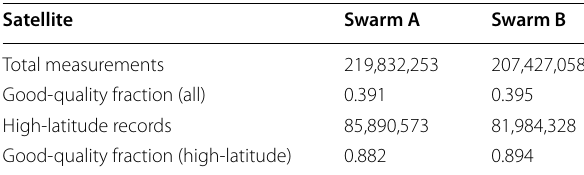
Table 5 TII cross-track ion drift dataset quality (TCT02 version 0302). Shown are the total number of records analyzed, the fraction of total cross-track horizontal (Viy) drifts flagged as good quality, and the fraction of high-latitude drifts flagged as good quality. Data quality is unavailable for Swarm C